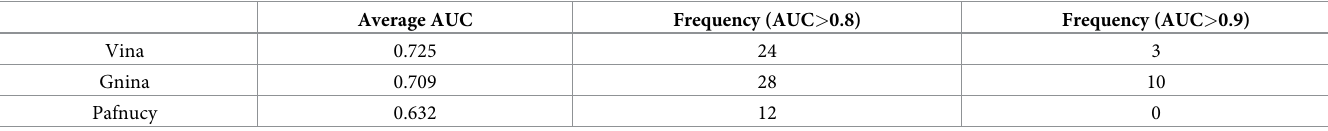
Table 4. Summary of Vina, Gnina and Pafnucy performance on DUD-E